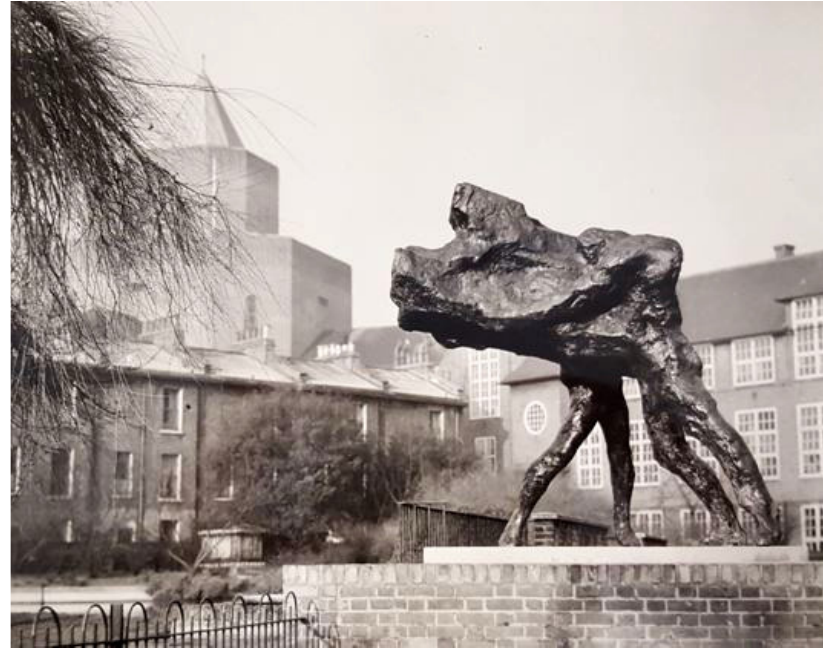
Figure 1. Sydney Harpley’s The Dockers , Lansbury Estate, installed in 1962. Source: Photograph of Sydney Harpley, The Dockers